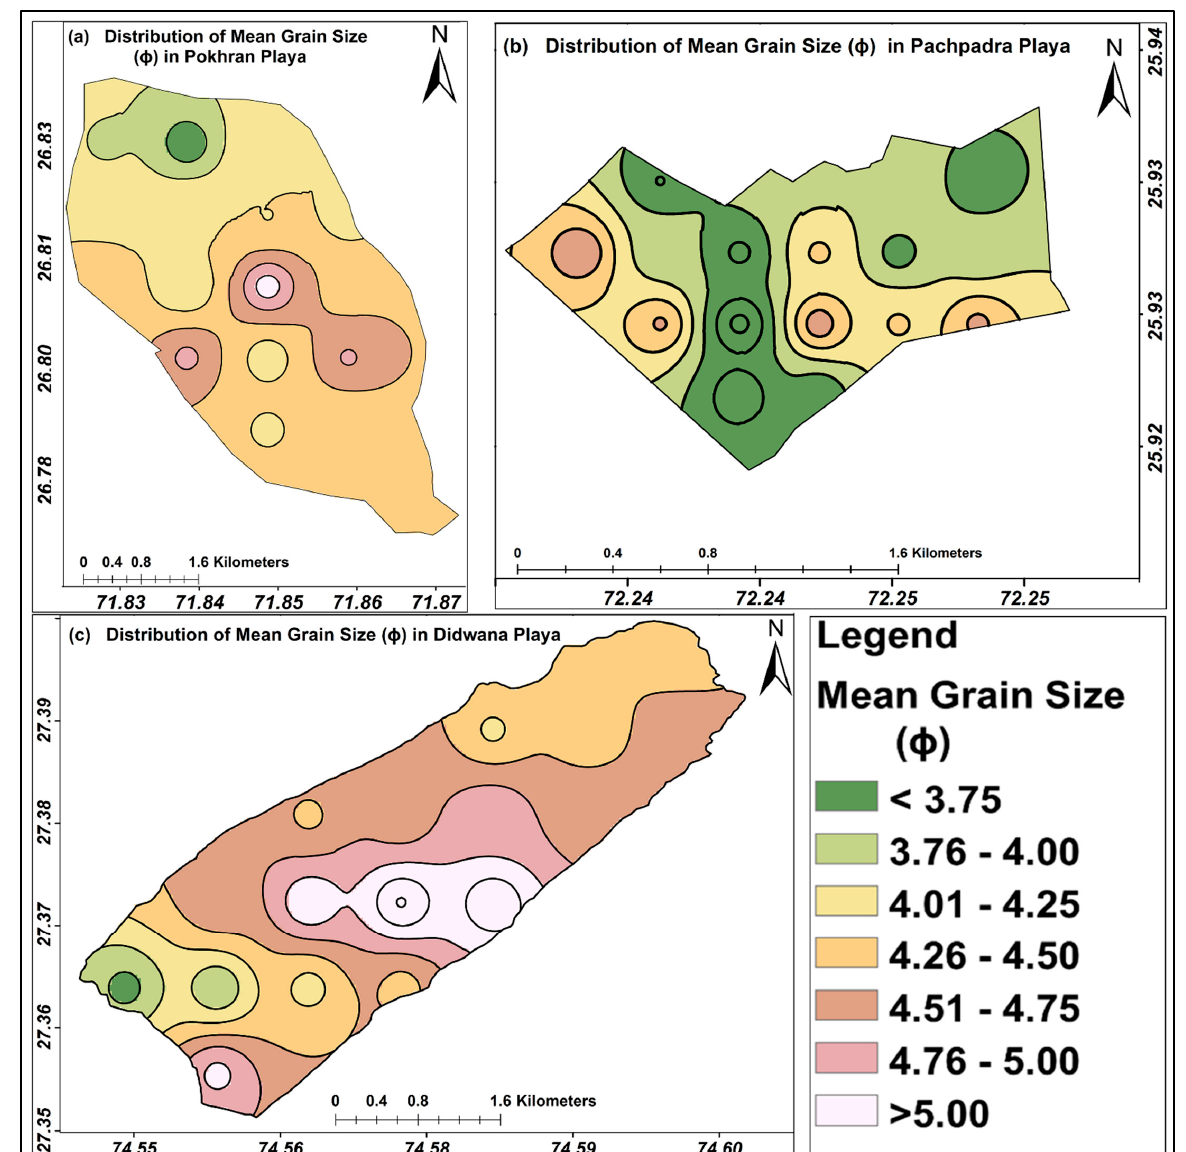
Figure 2. Distribution of Mean Grain Size ( ɸ ) in ( a ) Pokhran, ( b ) Pachpadra, and ( c ) Didwana playa.